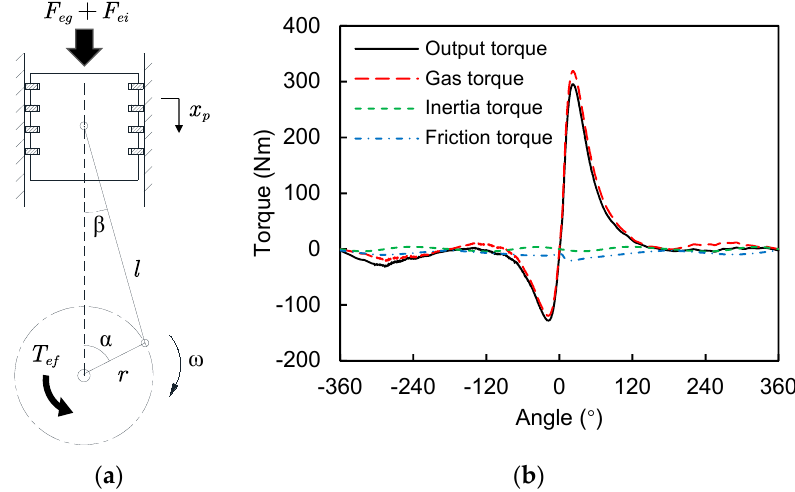
Figure 2. Transient model of engine. ( a ) Loads and motion of piston and crank − link mechanism; ( b ) transient torque of one cylinder at 750 rpm.